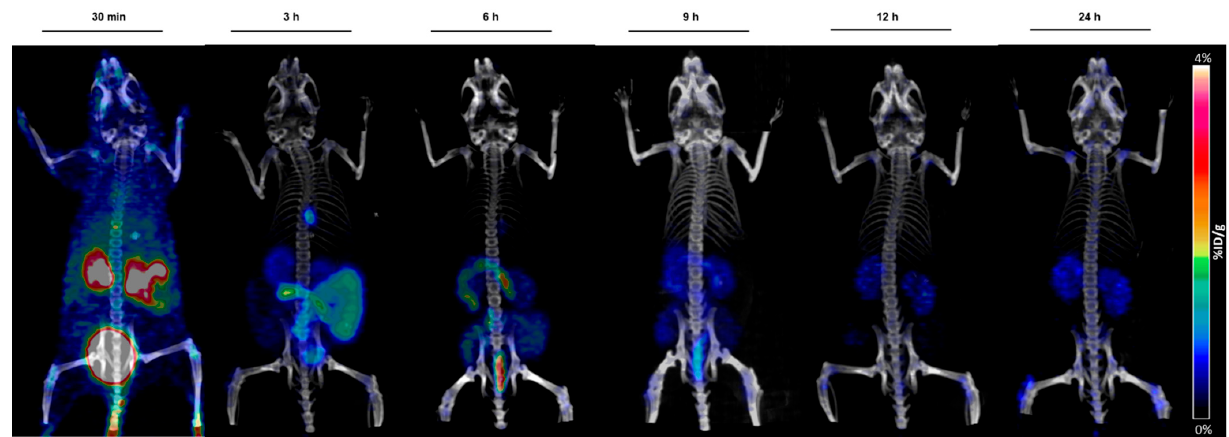
Figure 4. Maximum image projections (MIPs) obtained from static PET/CT scans at different time points. A hepatobiliary and renal excretion is clearly visible as well as a low accumulation in bones and kidneys 24 h p.i. Scale bar: 0–4%ID/g.